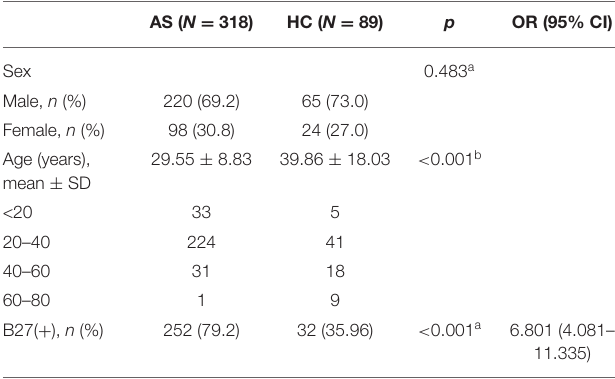
TABLE 1 | The basic information of all AS and controls (step